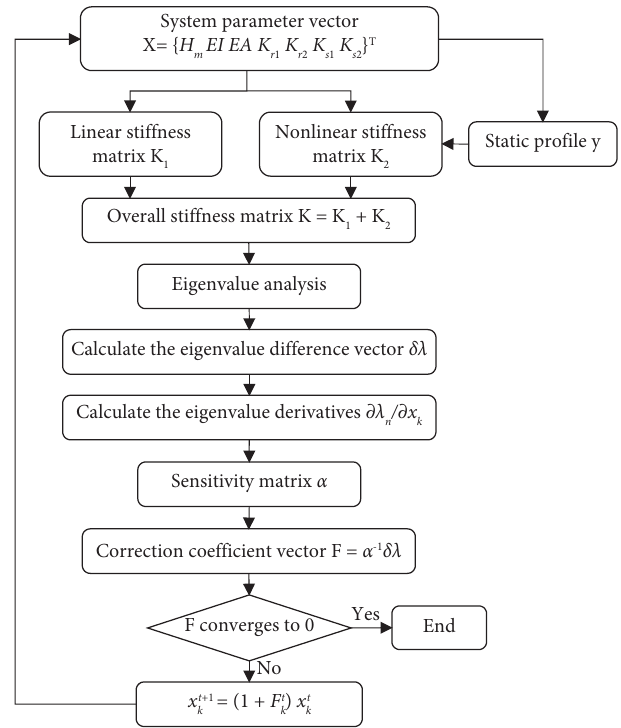
Figure 5: Block diagram of the sensitivity-updating algorithm for system parameter identifcation. Table 1: Physical parameters of four numerical